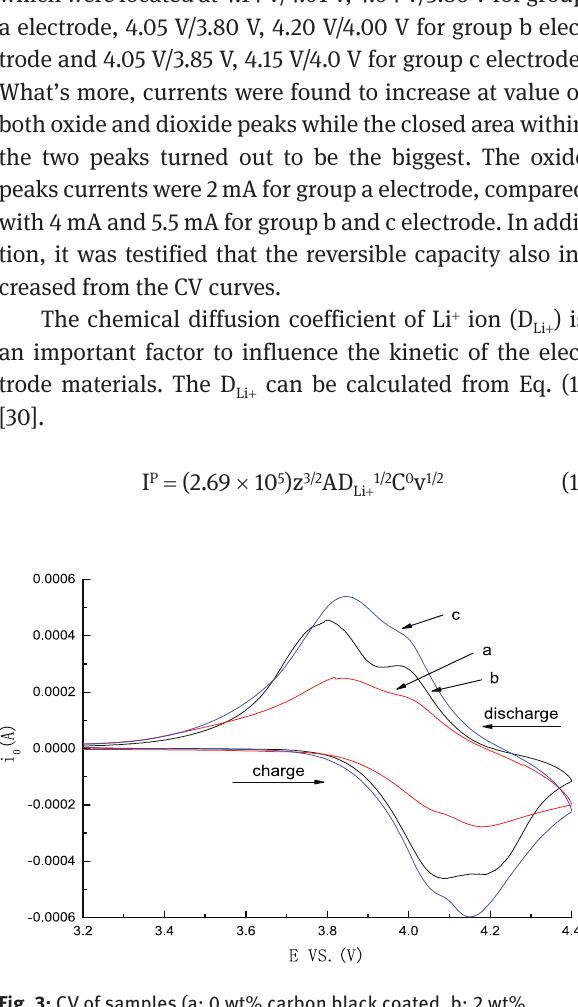
Fig. 3: CV of samples (a: 0 wt% carbon black coated, b: 2 wt% carbon black coated. c: 4 wt% carbon black coated)